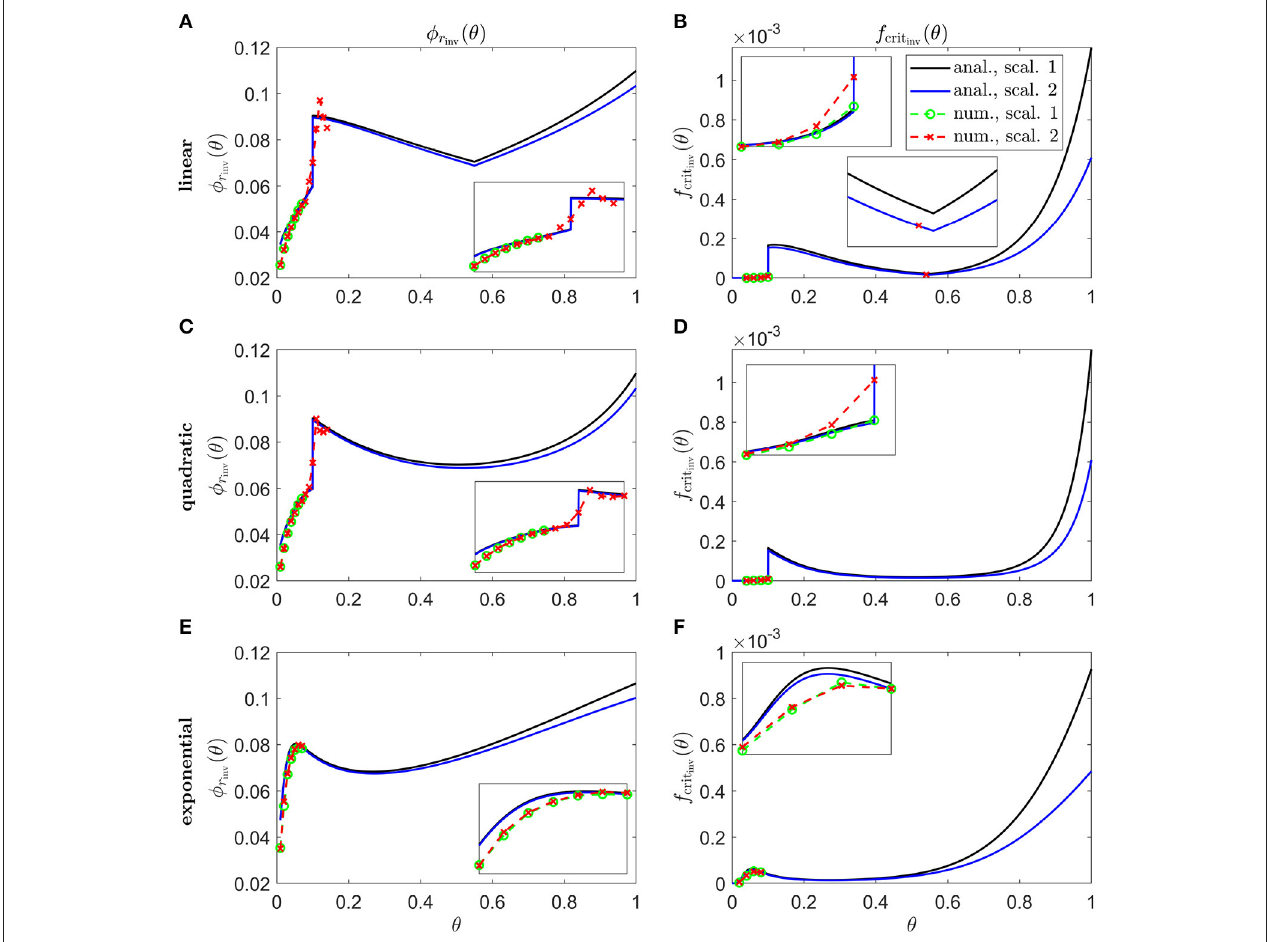
FIGURE 8 | Inverse mutation-induced rod degeneration rate and TF threshold concentration—Pattern 1B target cone degeneration profiles. (A,C,E) inverse mutation-induced rod degeneration rate, φ r ( θ ) ( f crit = 3 × 10 − 5 ); (B,D,F) inverse TF threshold concentration, f crit ( θ ) ( φ r = 7.33 × 10 − 2 ). (A,B) linear target cone inv inv degeneration profile, t degen ( θ ); (C,D) quadratic t degen ( θ ) profile; (E,F) exponential t degen ( θ ) profile. The solid black and dashed green curves correspond to Scaling 1 ( α = 7.01 × 10 4 and β = 1.79 × 10 6 ), while the solid blue and dashed red curves correspond to Scaling 2 ( α = 7.01 × 10 2 and β = 1.79 × 10 4 ). The black and blue solid curves are analytical approximations to the inverses, obtained by plotting Equations (7) and (10), respectively, (A,C,E) , and Equations (8) and (11), respectively, (B,D,F) . The green and red dashed curves are numerical inverses, obtained by using the Matlab routines fminsearch (A,C,E) , and patternsearch (B,D,F) to calculate the φ r and f crit profiles for which the contour described by p c ( θ , t ) / ˜ p c ( θ ) = 0.99 matches the target cone degeneration profile, t degen ( θ ). Equations (1–5) were solved at each iteration using the method of lines, with 51 or 101 mesh points. Insets show magnified portions of each graph. Numerical inverses are calculated and plotted only at those locations (eccentricities) where the analytical inverse fails to generate a t degen ( θ ) profile matching the target profile. Inverses resemble vertically flipped versions of the t degen ( θ ) profiles. Numerical solutions reveal lower values of the inverses near the fovea ( θ = 0) than the analytical approximations suggest and higher values in some regions away from the fovea in (A–D) . Cone degeneration profile formulas and parameters are given in Table 3 . Remaining parameter values as in Table 2